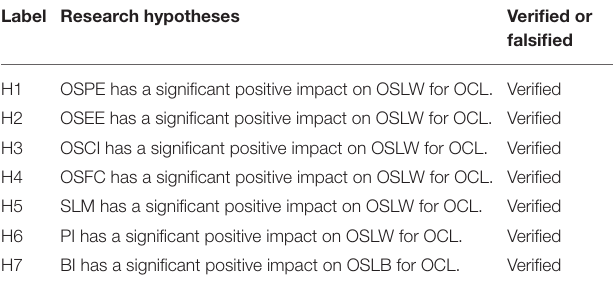
TABLE 5 | Hypothesis test